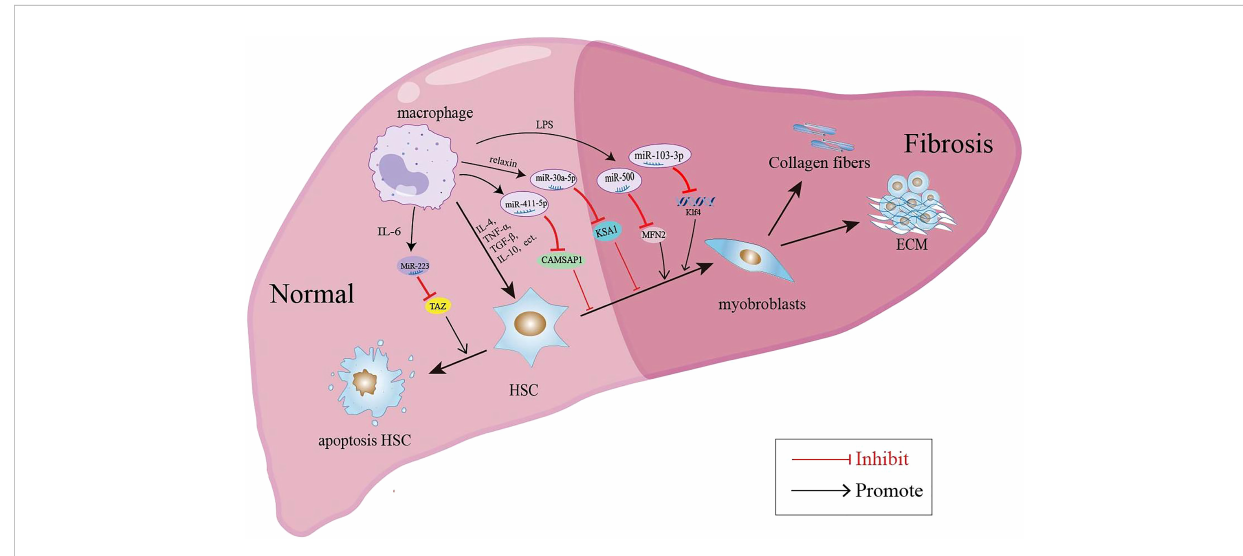
FIGURE 1 Macrophage-derived exosomal miRNAs regulate the activation and apoptosis of HSCs involved in the pathology of liver fi